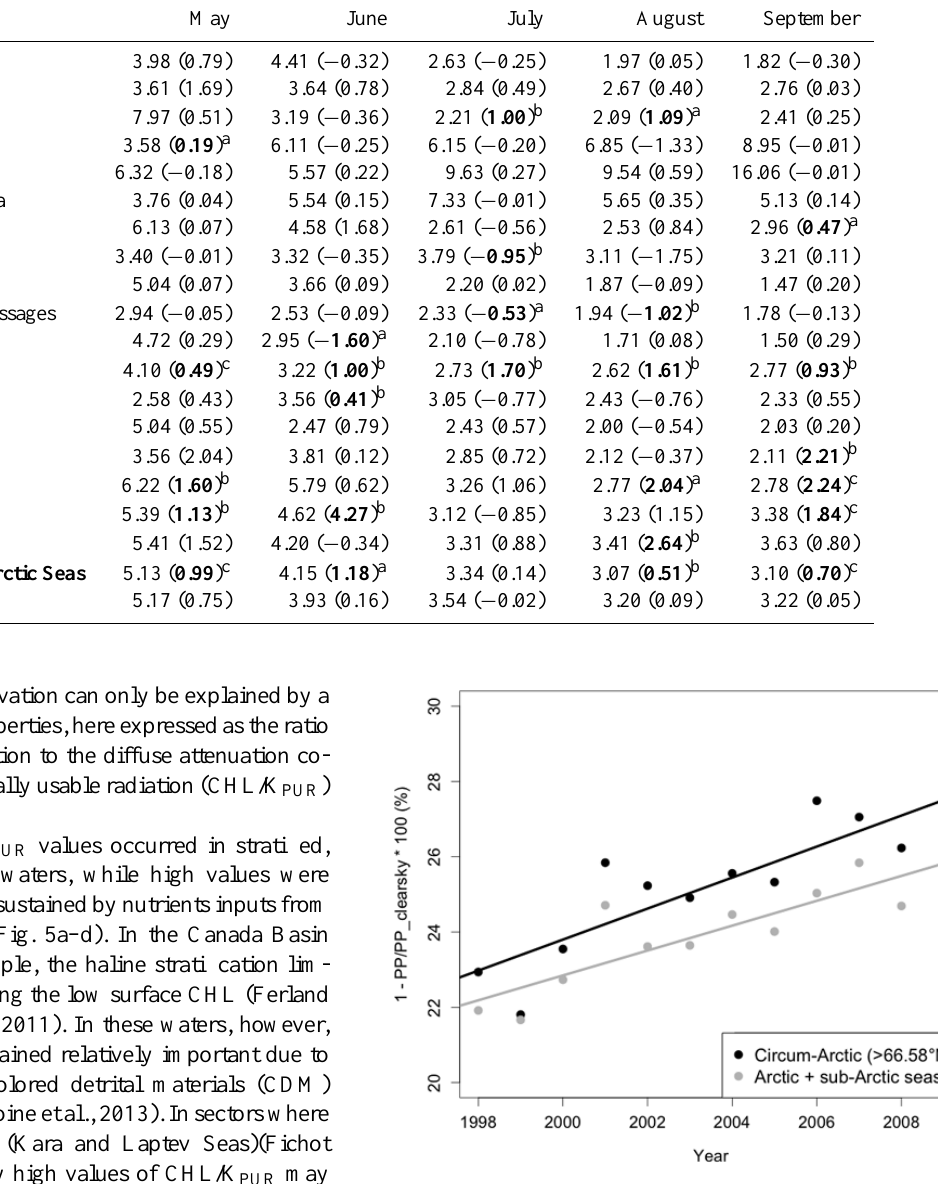
Fig. 6. Trends in the potential reduction of total annual PP due to cloudiness (in %) as estimated using 100 ∗ ( 1 − PP/PP clearsky ) inte- grated over the circum-Arctic (lat. above 66.58 ◦ N) and over all arc- tic and sub0arctic seas. PP clearsky is the total annual PP calculated assuming clear sky contidtions. Linear trends statistics are presented in Table